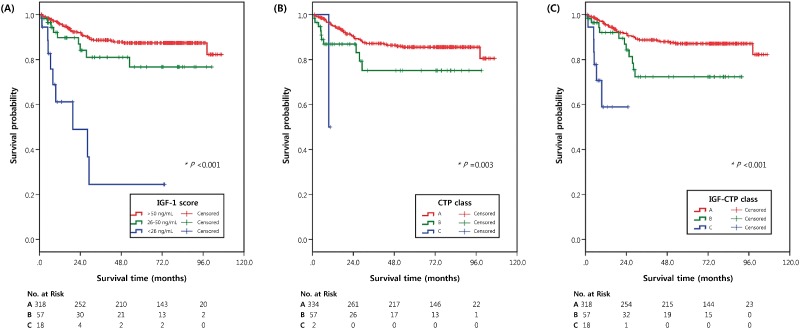
Kaplan-Meier survival curves of patients classified by serum levels of IGF-1 (A), CTP class (B), and IGF-CTP class (C).Tables below each graph show the numbers of patients at risk at various time points.